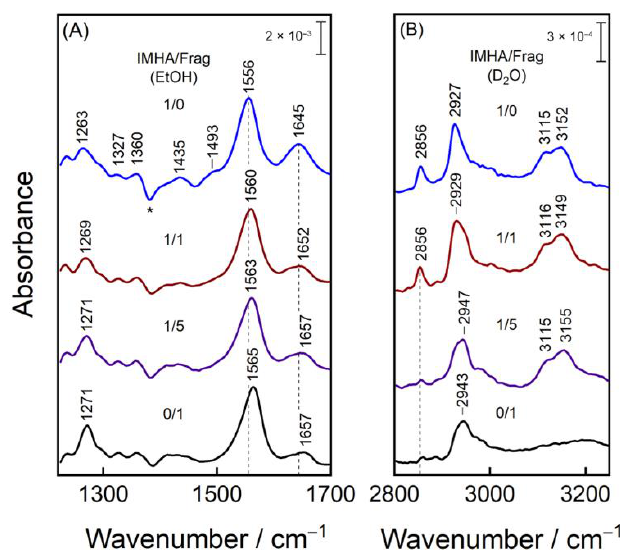
Figure 6. ( A ) SEIRAS spectra of IMHA, binary IMHA/Frag (1/1 and 1/5), and Frag SAMs at the 90th adsorption minute in ethanol incubation solution in 1220–1700 cm − 1 spectral range. Asterisk marks the negative band, which appears due to the withdrawal of ethanol molecules from the Au surface. ( B ) Spectra of the same composition SAMs after the careful ethanol exchange with D 2 O in the spectral range of 2800–3250 cm − 1 .